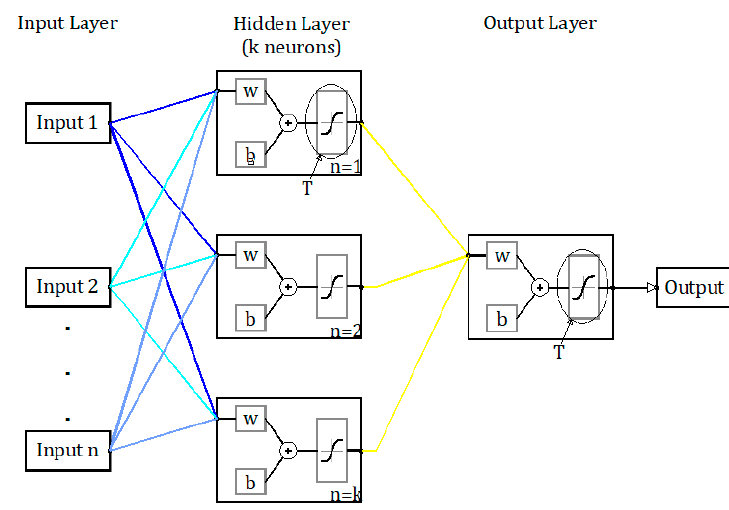
Figure 3. Neural Network Pattern: one input layer, one hidden layer and one output layer (T = transfer function, b = bias value, w = connection weight).